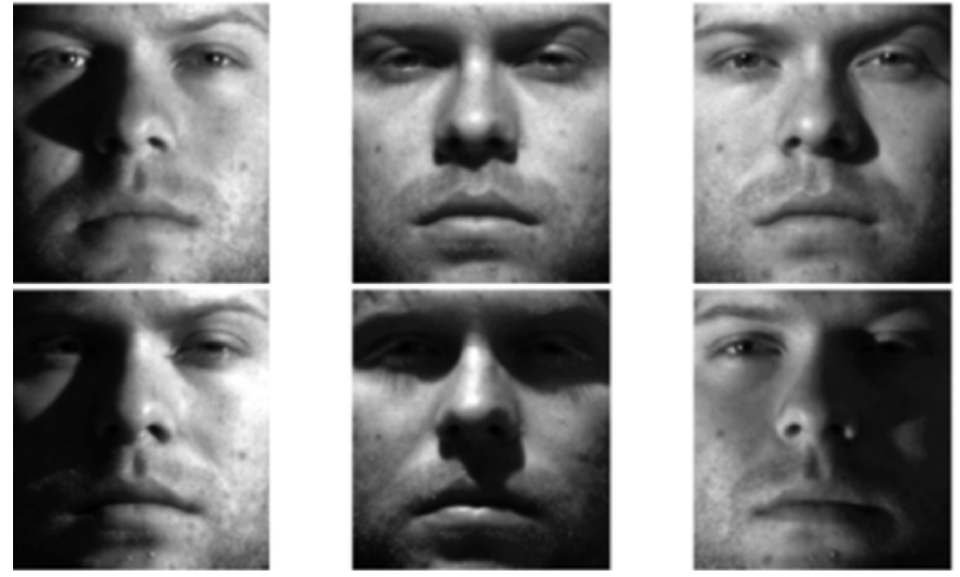
Figure 2. Preview of the Yale Face Dataset B Cropped [45] .